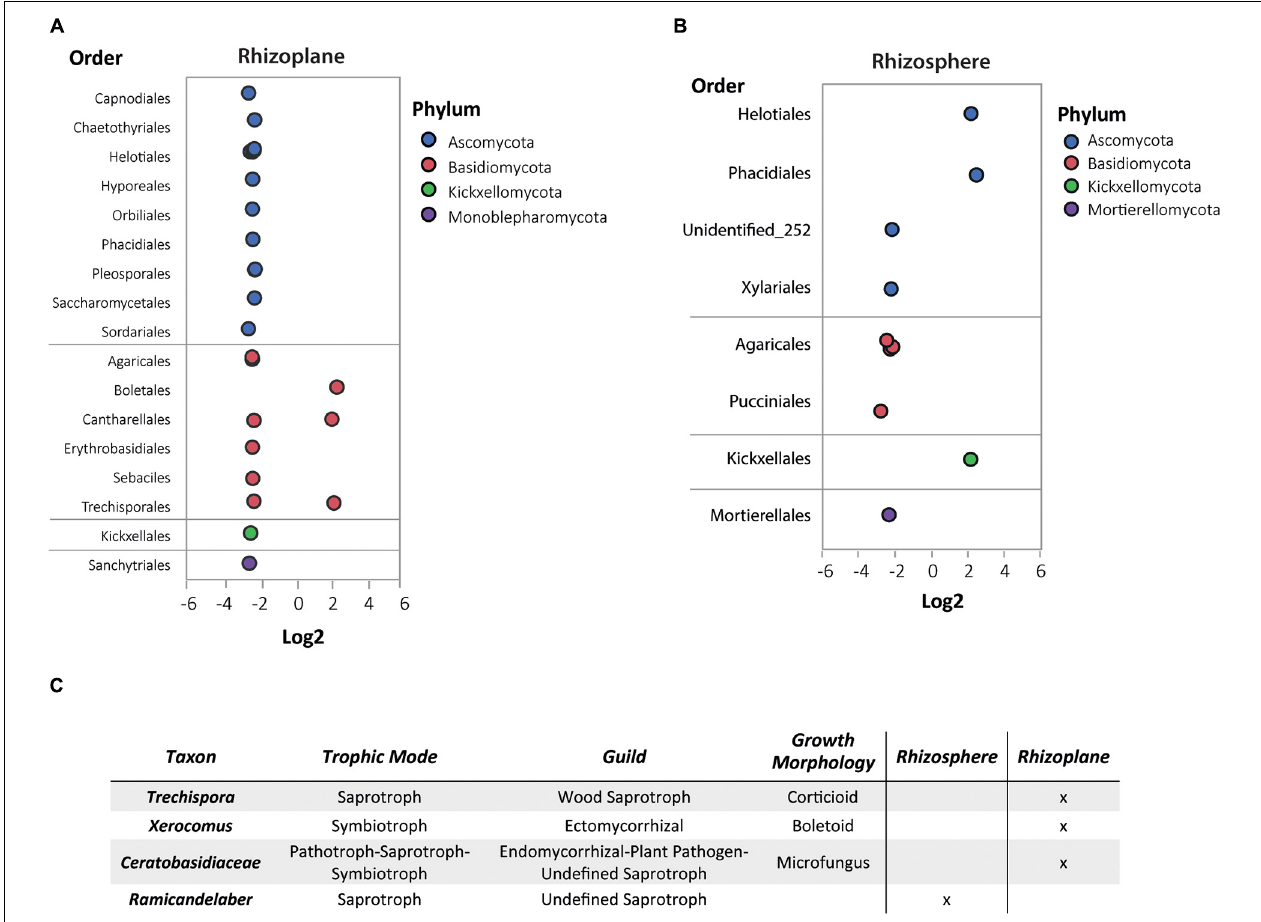
FIGURE 7 | Differential abundance analysis (DAA) and guilds of fungal OTUs in N. brachypetala and non-hyperaccumulator species. Bubble plots of the differential abundant fungal OTUs in the rhizoplane (A) and rhizosphere (B). The x axis indicates the log2 ratios (hyperaccumulators vs. non-hyperaccumulators). The y axis indicates fungi at the taxonomical level of order. Bubble colors indicate the associated phylum. (C) Table of trophic mode and guilds of DAA fungi in N. brachypetala in each root